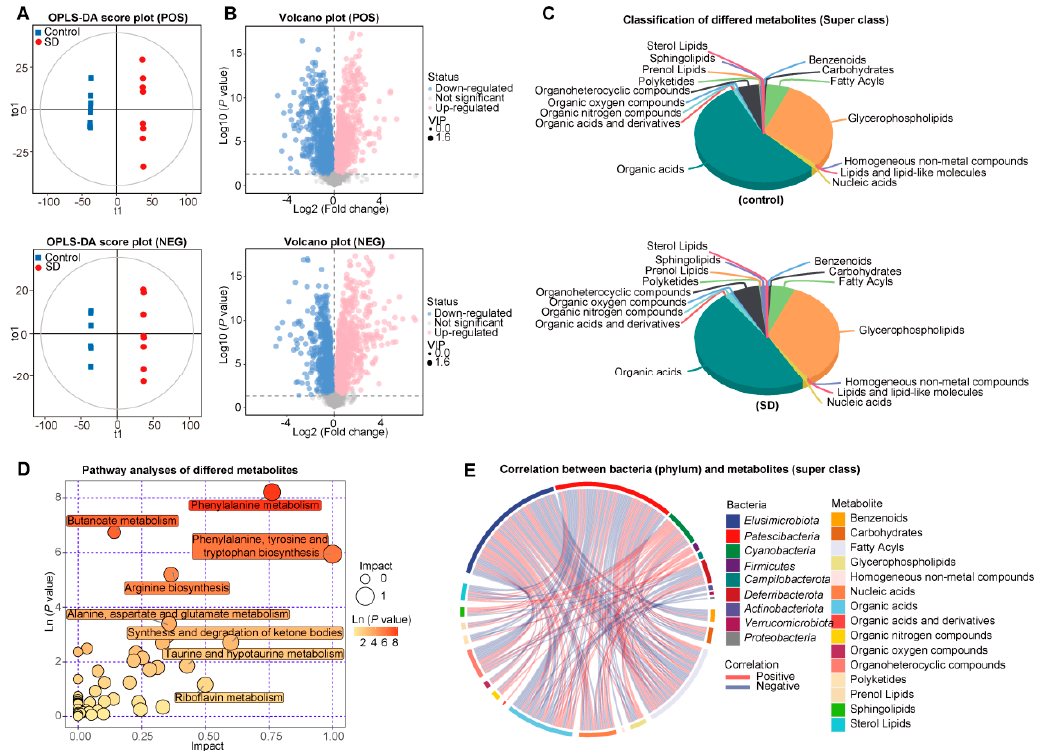
Figure 3. Changed metabolic patterns in plasma of SD mice. ( A ) Score scatter plots of orthogonal PLS-DA (OPLS-SA) comparing the plasma metabolic differences show the separation between control and SD in ES+ and ES − . ES+, positive ion mode; ES − , negative ion mode. ( B ) Volcano plots for the alterations of plasma metabolites between ES+ and ES − groups. Metabolite at p < 0.05 and variable importance (VIP) in the projection threshold of >1 was significantly different. Downregulation and upregulation were determined by fold-change. ( C ) Pie chart showing the proportion of metabolite annotated to the classification of superclass based on the metabolomics workbench. ( D ) Bubble analysis of metabolic KEGG pathways between control and SD group. ( E ) Circos plots showed Spearman’s correlation analysis (p<0.05) between phyla and metabolites classified based on the superclass. Red indicates a positive correlation, and blue indicates a negative correlation. Each phylum and metabolic superclass were seen in a different color.